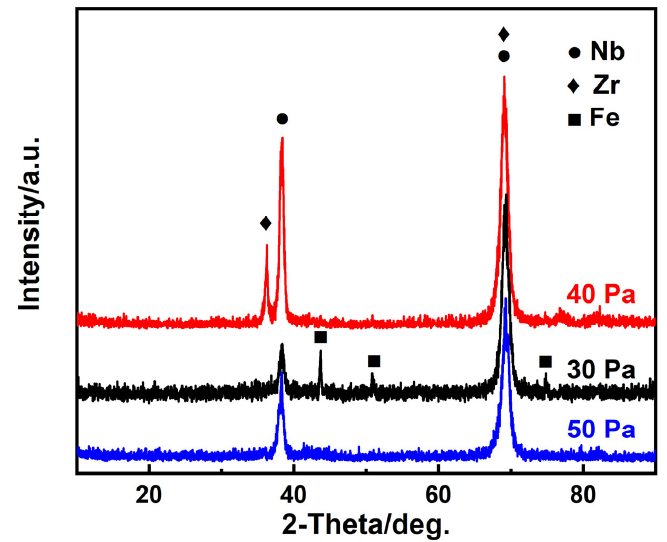
Figure 2. XRD patterns of Nb ‐ Zr prepared at pressures of 30 Pa, 40 Pa, and 50 Pa.